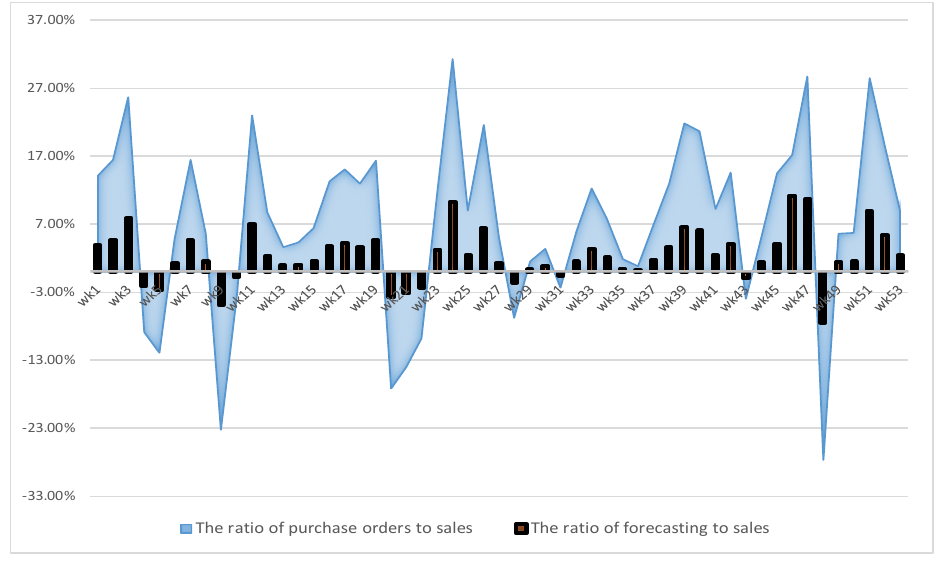
Figure 4. Comparison of prediction methods.